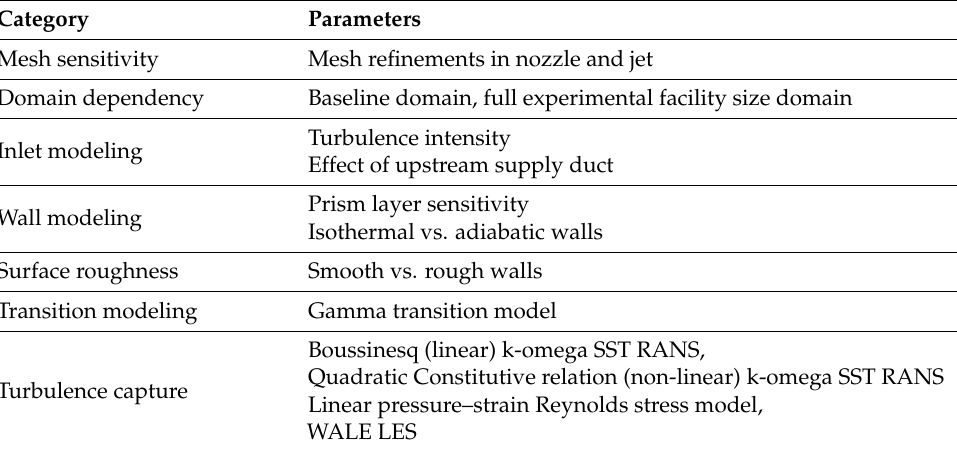
Table 1. Improvement parameters considered in RANS